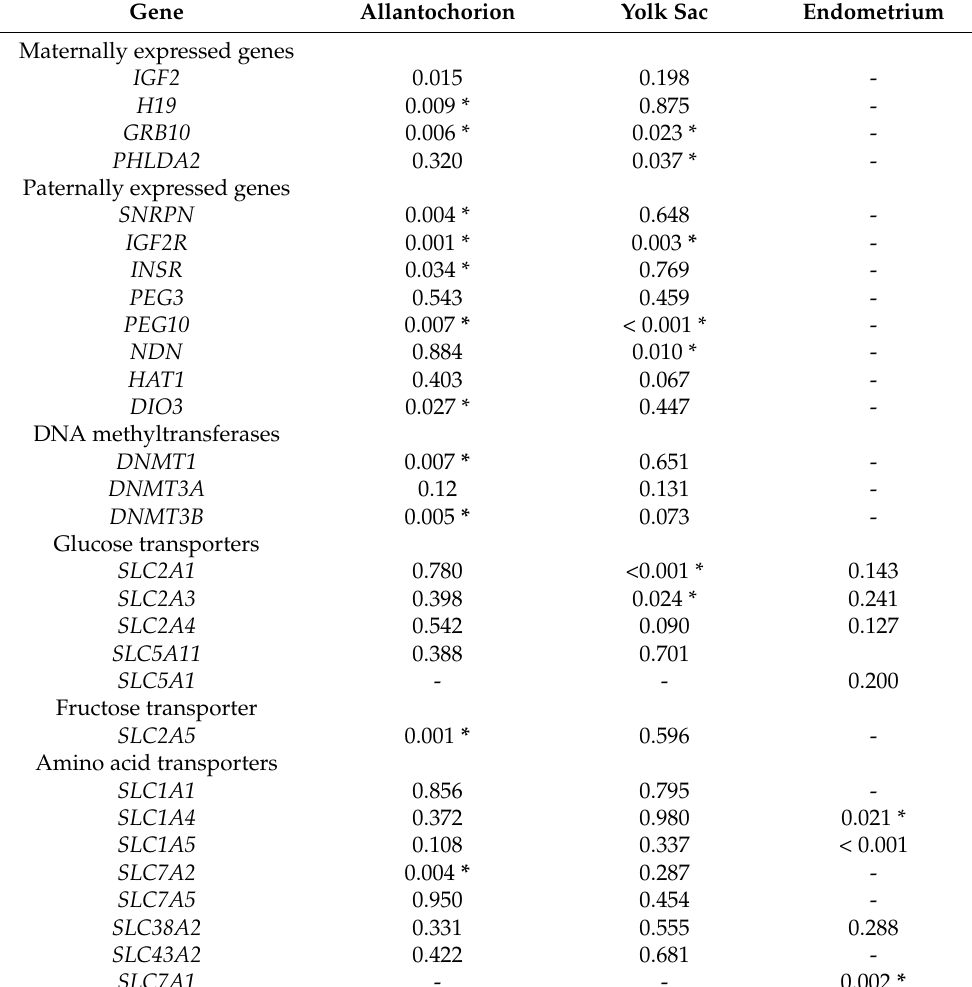
Table 5. p values for the difference (main group effect) in expression for selected genes in allanto- chorion and yolk-sac membranes and endometrial tissue recovered from Shetland pony mares on day 28 of gestation following transfer of embryos between overfed and control mares on day 7 after ovulation. p values < 0.05 are indicated by a